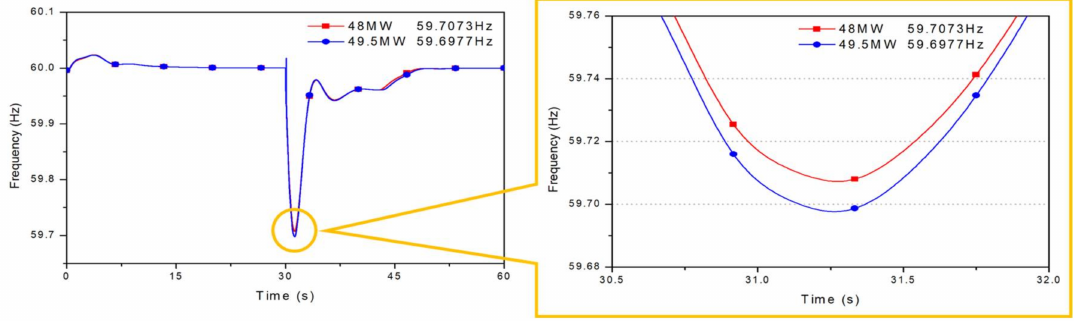
Figure 9. Frequency of Jeju power system on the merit order 1 when the wind farm is lost.